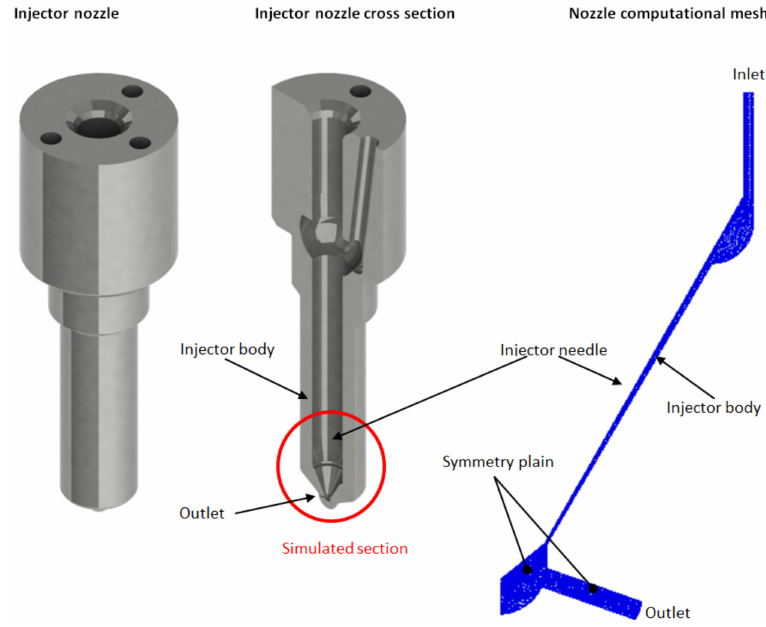
Figure 3. Injector muzzle model and computational mesh in the